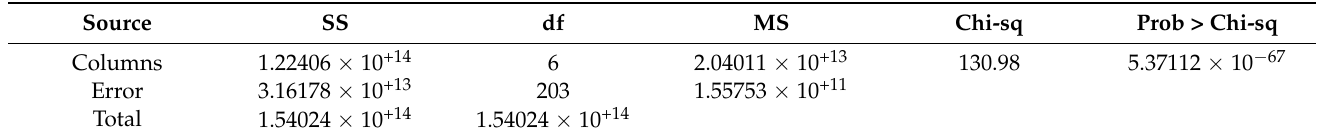
Table 8. ANOVA testing for test system 3.